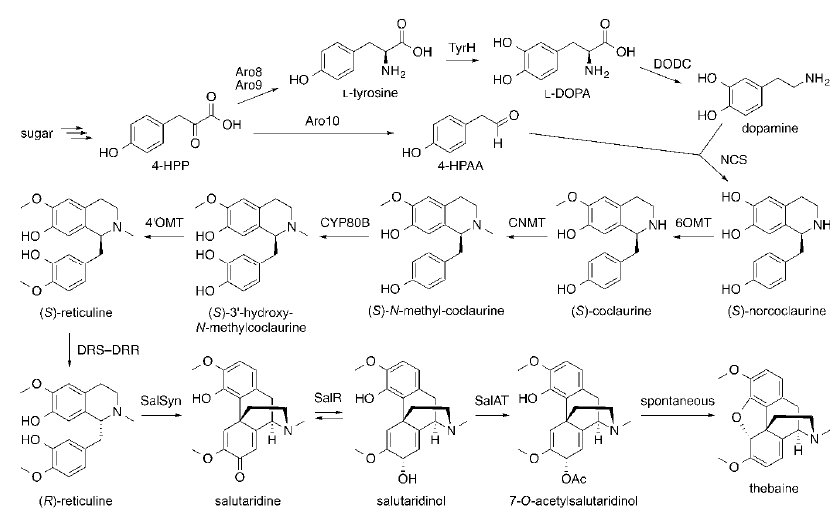
Figure 15. Heterologous biosynthetic pathway installed in Saccharomyces cerevisiae for de novo production of morphinan alkaloids and their semi-synthetic compounds from simple sugar [78]. Only the pathway leading to the formation of the key biosynthetic intermediate thebaine is shown. For the biosynthetic pathway leading to the formation of morphine and semi-synthetic morphinan opioids, see Figure 14. 4-HPP, 4-hydroxyphenylpyruvate; 4-HPAA, 4-hydroxyphenylacetaldehyde; L -DOPA,